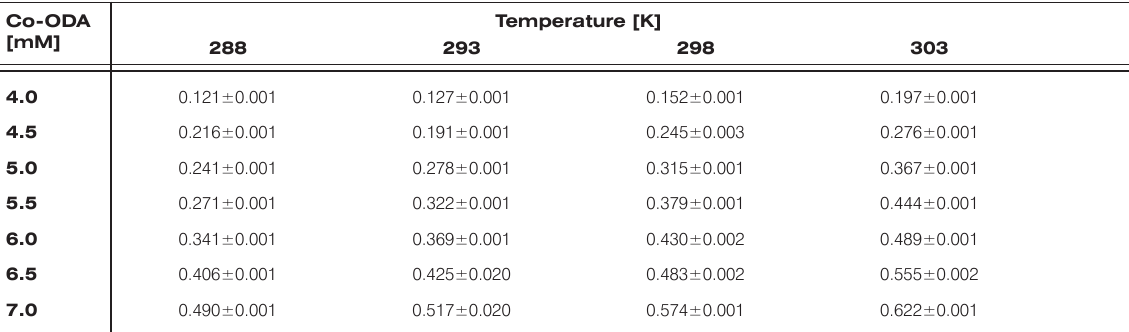
Table 4. Concentration and temperature dependences of rate constants k (s -1 ) (± standard derivation) of the substitution of Co-ODA with phen. The concentration of phen is constant and equals to 2.88